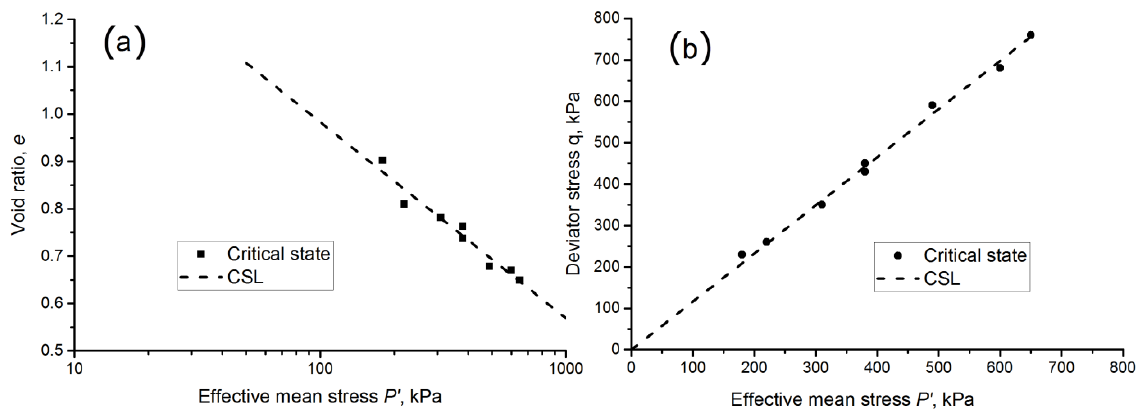
Figure 8. Critical states of the intact soil ( a ) the e-log p' space, ( b ) the deviator and mean effective stresses q-p' space 240